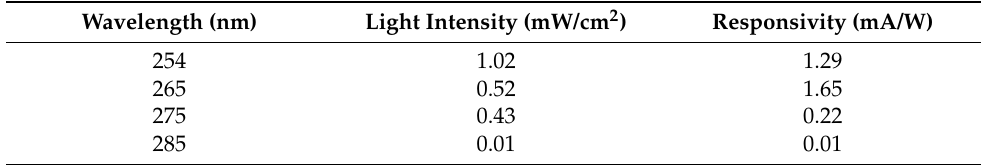
Table 1. The responsivity of the NaTaO 3 /TiO 2 -based detectors under different UV illumination. Wavelength (nm) Light Intensity (mW/cm 2 ) Responsivity (mA/W) 254